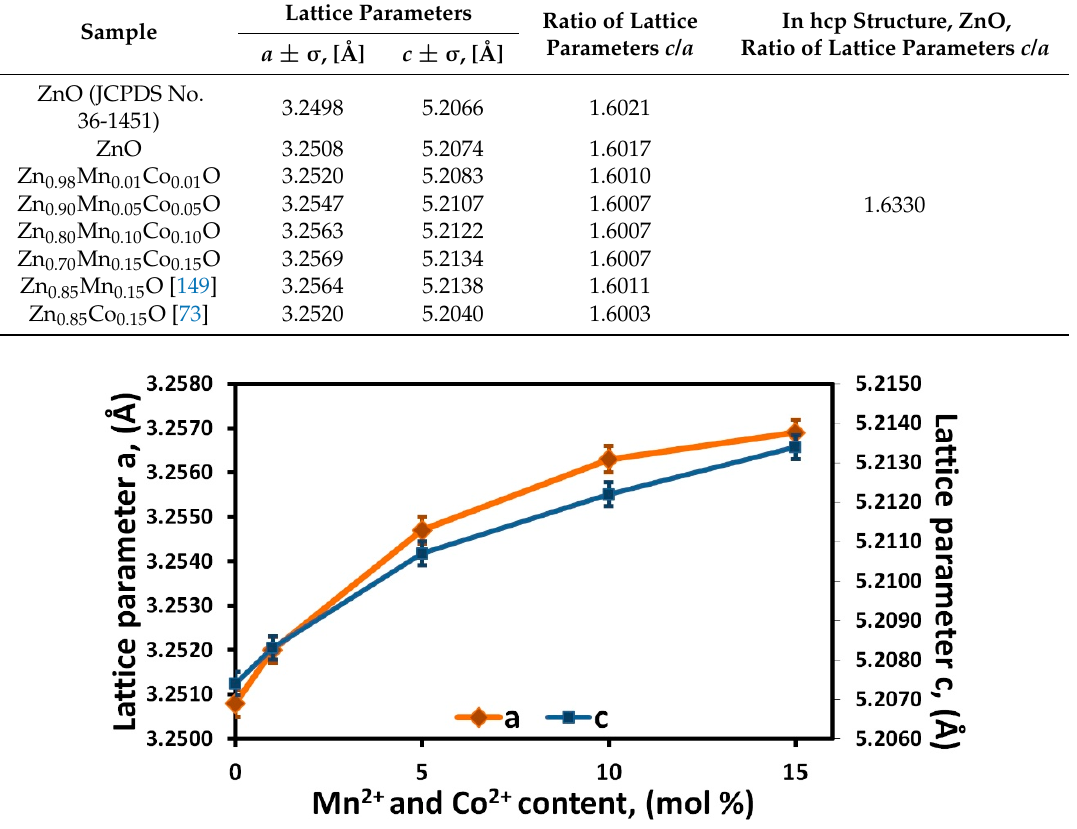
Figure 6. Lattice parameters versus nominal dopants content of Zn (1 − x − y) Mn x Co y O NP samples.